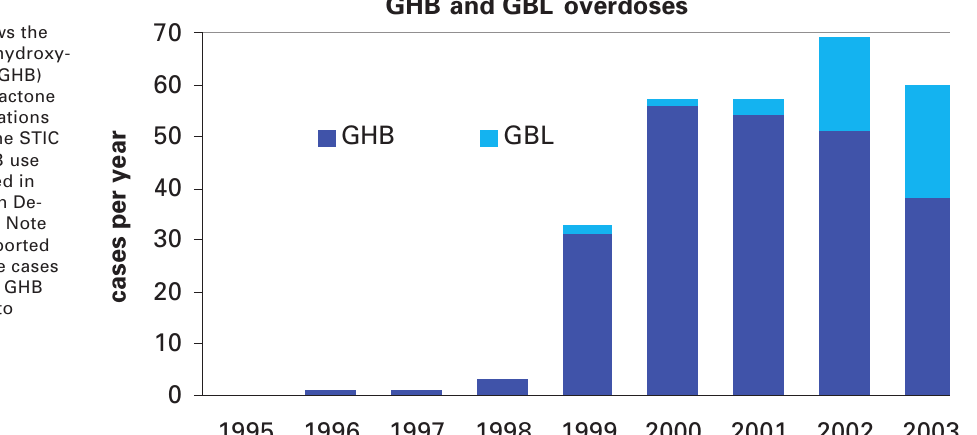
Figure 1 shows the number of g -hydroxy- butyric acid (GHB) and g -butyrolactone (GBL) intoxications reported to the